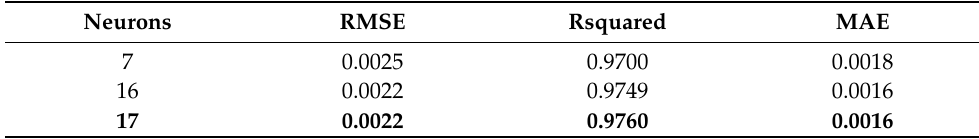
Table 3. Bayesian regularized neural network.